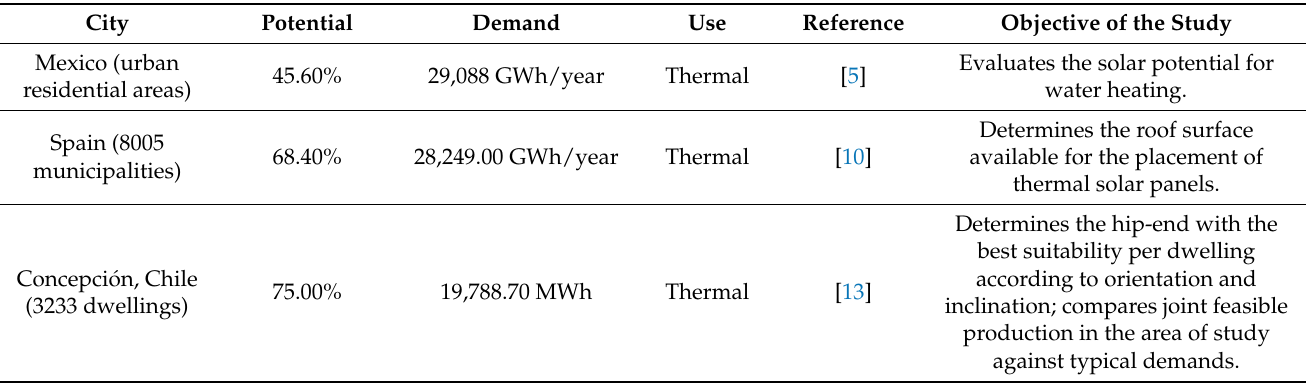
Table 1. Technical energy potential for different